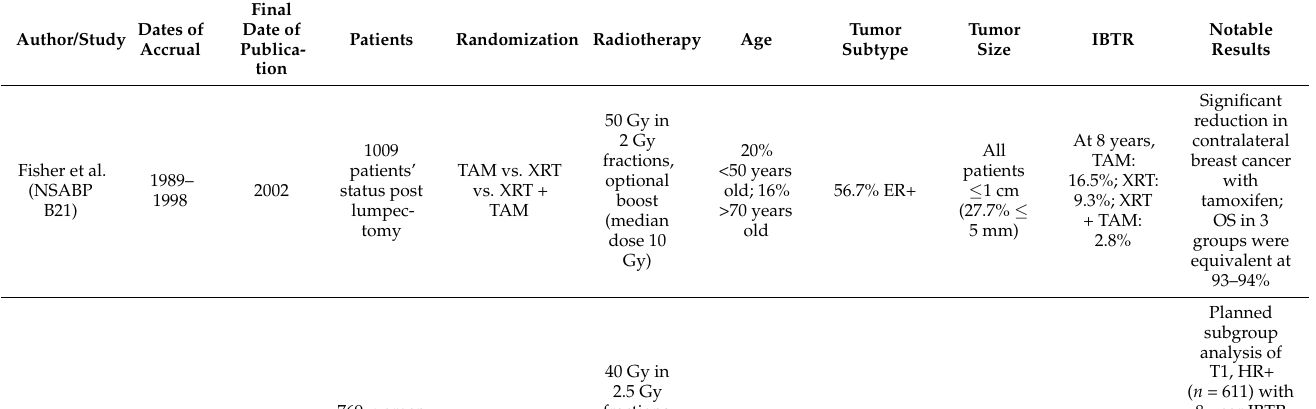
Table 1. Clinical trials on the omission of radiation therapy in early-stage breast